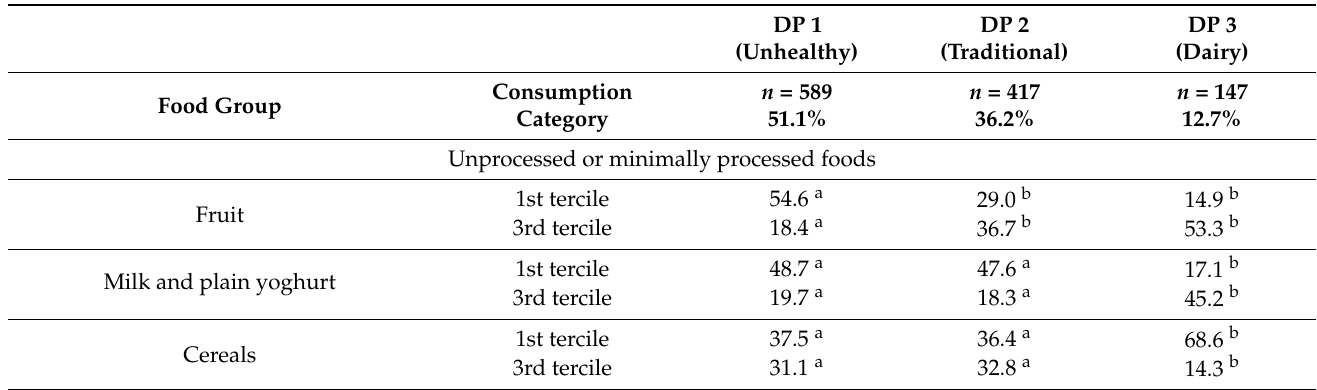
Table 1. Weighted prevalence * of subjects within consumption categories in each dietary pattern—Portuguese population aged 3–17 years: The UPPER